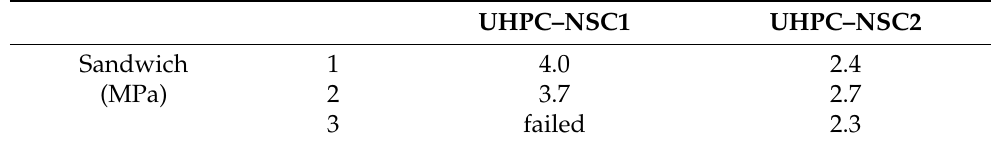
Figure 8. Sandwich sample in the hydraulic loading machine after testing. Table 3. Shear strength of the sandwich